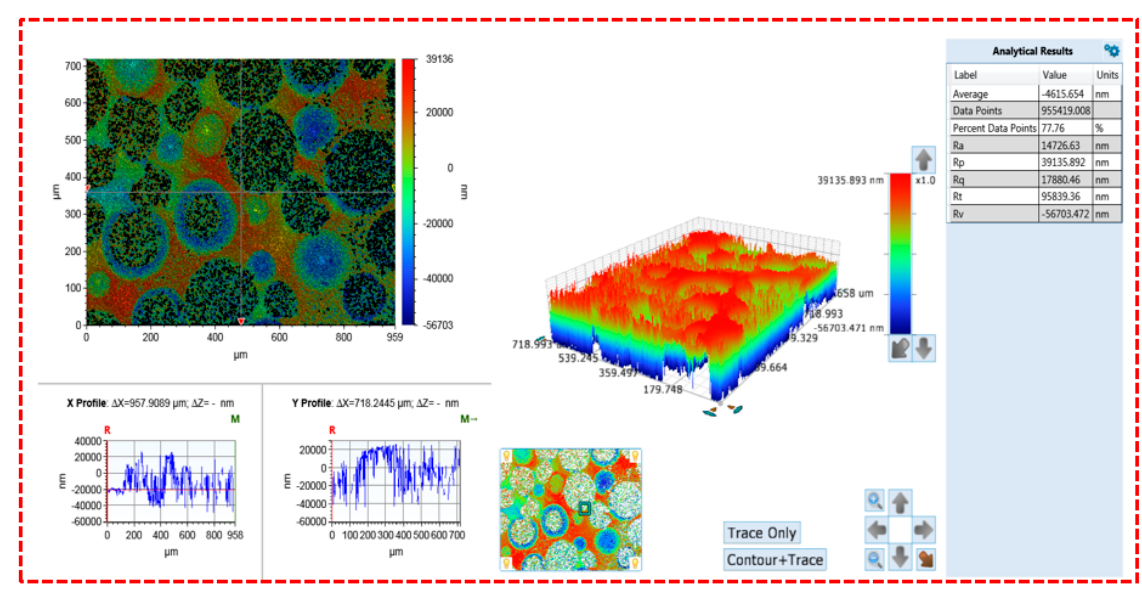
Figure 5. 2D and 3D morphologies of the polyurethane polishing pad.